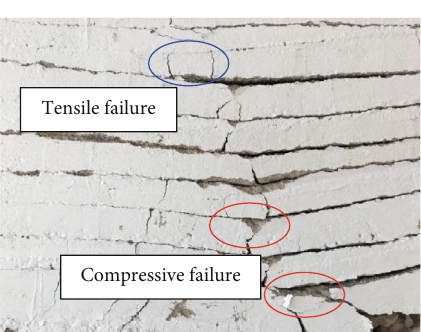
Figure 2: Characteristics of vertical fractures in simulated layered